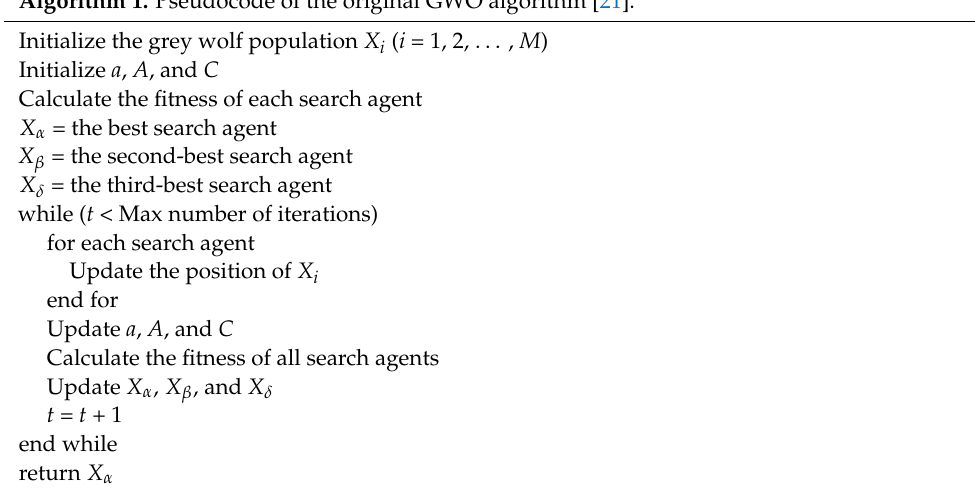
Algorithm 1. Pseudocode of the original GWO algorithm